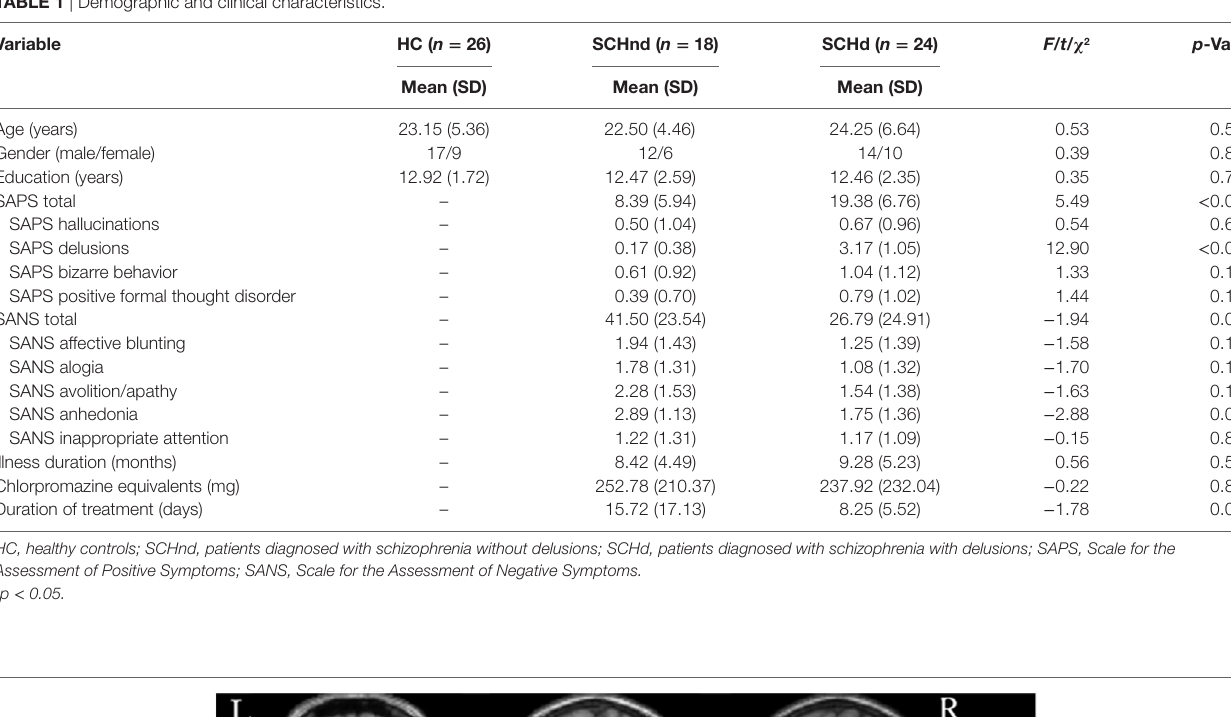
TaBle 1 | Demographic and clinical